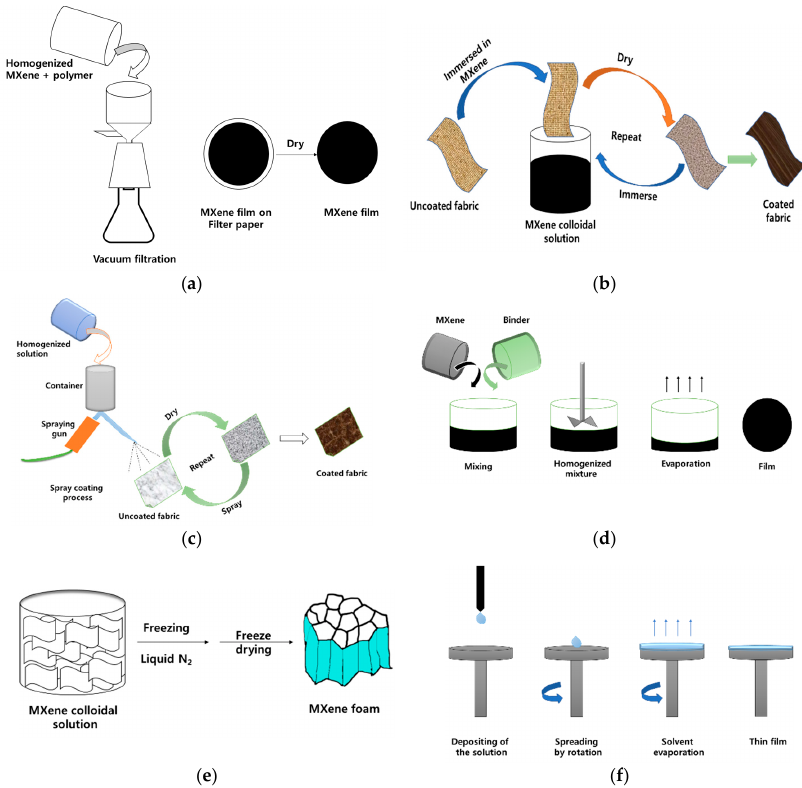
Figure 8. Schematic representation of: ( a ) vacuum assistant filtration (VAF), ( b ) dipped coating, ( c ) spray coating ( d ), solvent casting, ( e ) freeze drying, and ( f ) spin coating.